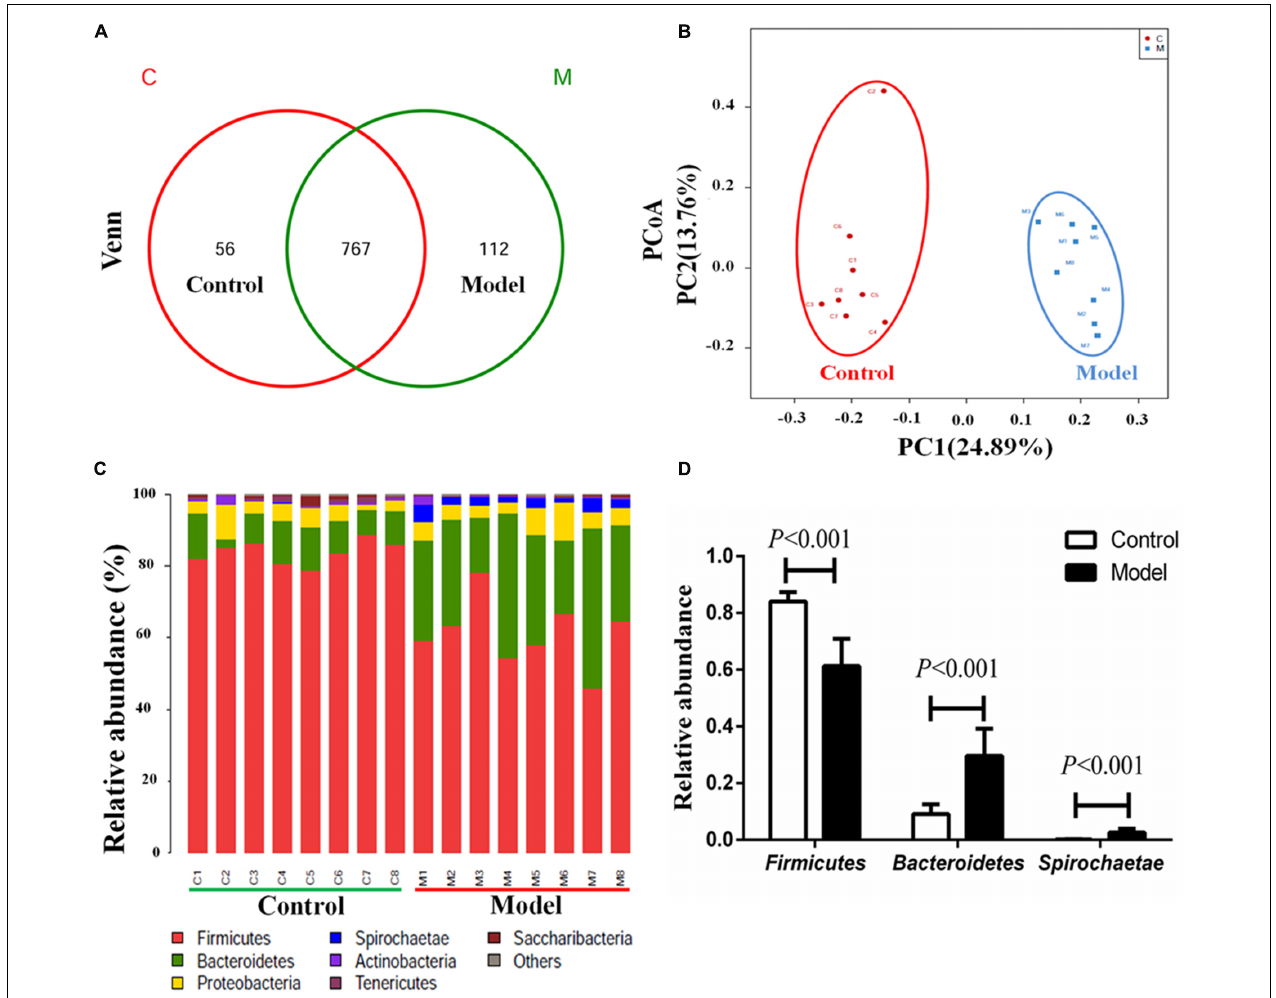
FIGURE 2 | Isoproterenol-induced AMI leads to significant alterations of microbiota composition profiles in cecal contents. (A) Venn diagram of the shared OTUs between model group and control groups in cecal contents. (B) The PCoA score plots of cecal OTUs between the control and model groups. (C) The relative abundance of cecal microbiota at phylum level in the two different groups. (D) The relative abundance of Firmicutes , Bacteroidetes and Spirochaetae in the cecal control and model groups.